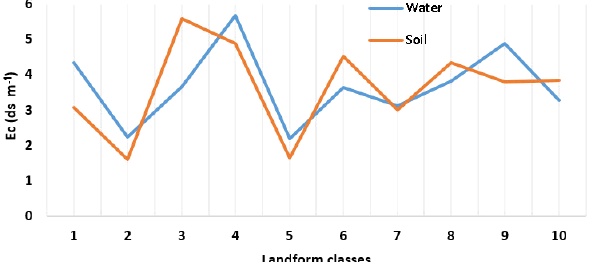
Figure 9. Relationship between landform